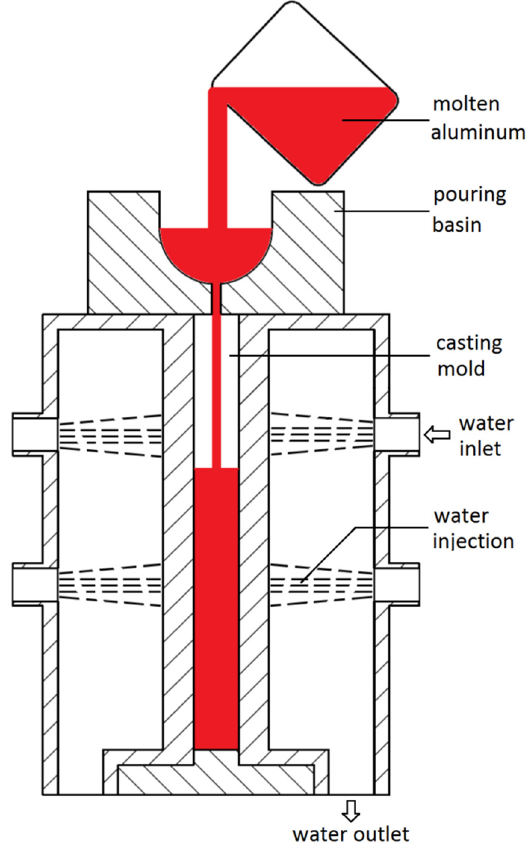
Figure 1. Schematic sketch of the double ‐ side water cooling casting apparatus. Table 1. Chemical composition of alloy samples, wt %. Bal. means balance.